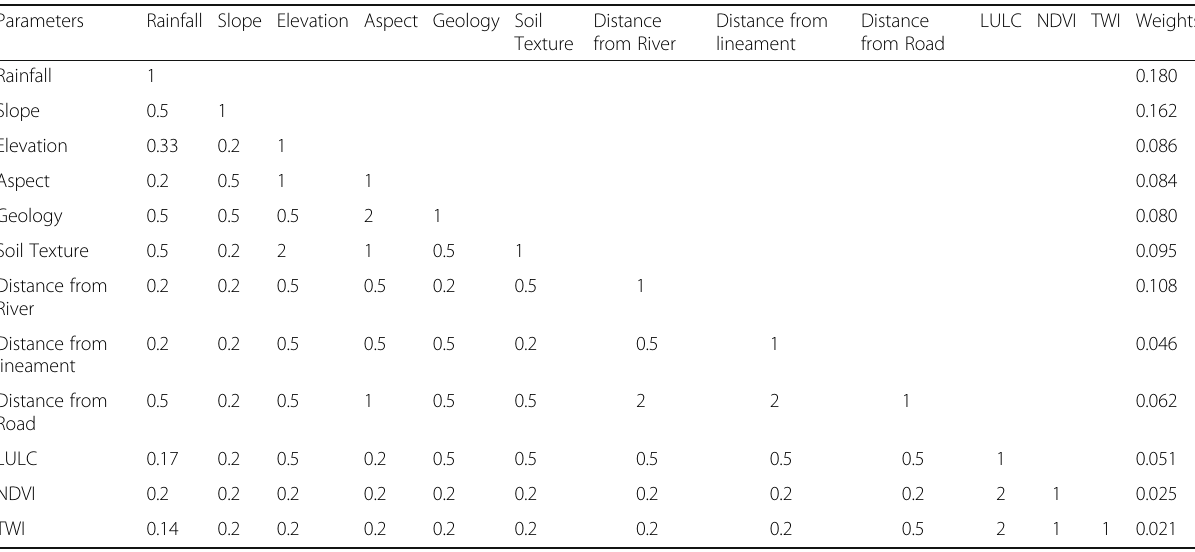
Table 5 Parameters wise weights, matrix and consistency ratio using AHP